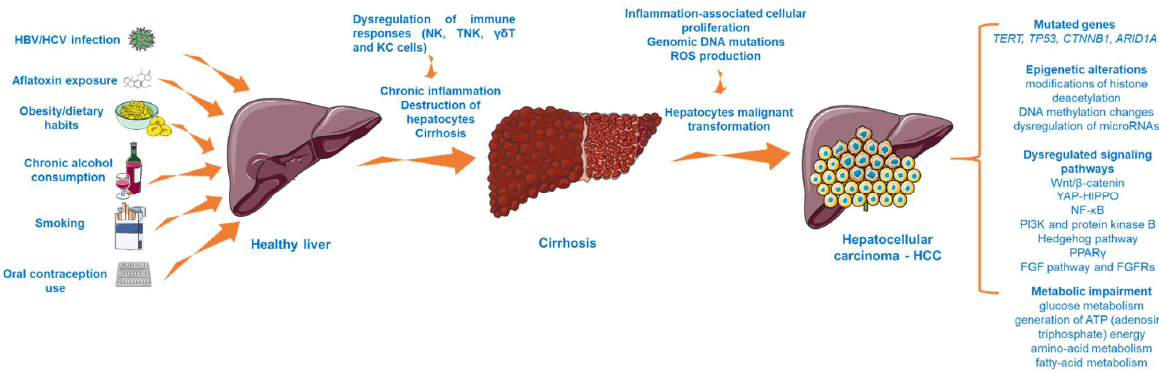
Figure 1. The multistep process involved in HCC development. This image contains Servier Medical Art elements, which are licensed under a Creative Commons Attribution 3.0 Unported License; https://smart.servier.com, accessed on 20 June 2021. The following abbreviations are used in the figure: HBV—hepatitis B virus; HCV—hepatitis C virus; NK—natural killer cells; TNK—natural killer T cells; KC—Kupffer cells; ROS—reactive oxygen species; TERT—telomerase reverse transcriptase; TP53—tumor protein 53; YAP-HIPPO—Yes-Associated Protein-Hippo Pathway, PPARγ—peroxisome proliferator-activated receptor gamma; FGF—fibroblast growth